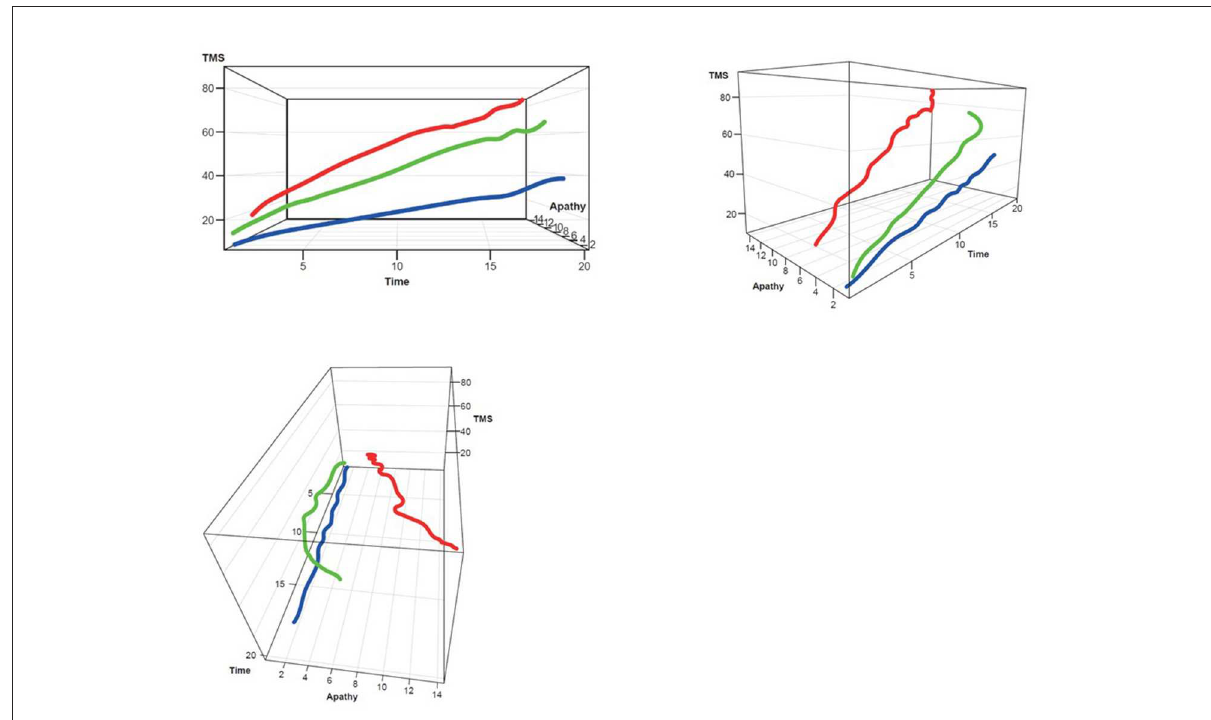
FIGURE4 TMS–Apathy 3D plot for clustering. Red , rapid progressors; Green , moderate progressors; Blue , slow progressors; TMS, Total Motor Score.